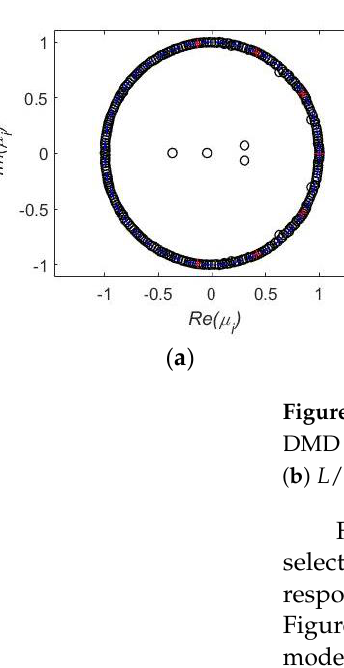
A comparison between the PSD of the 𝐶 𝐿 of the DC and the DMD spectrum was performed, as indicated in Figure 15. Modes chosen by using the SPDMD algorithm could correspond well to the different frequency peaks in the PSD. According to Figure 15b, more modes were required to completely reproduce the dynamic information of the coherent flow structures in the wake regions behind both UC and DC for distance ratio 𝐿/𝐷 = 2.5, due to the flow complexity compared with the other two cases. As has been explained in Section 3.2, there are strong interactions between the shear layers with large amplitudes of transverse oscillation behind the UC and DC. Therefore, several peaks were observed in PSD at 𝐿/𝐷 = 2.5 .